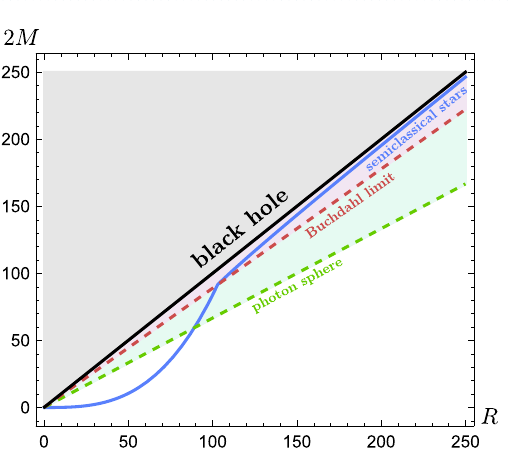
Figure 3. The left and right panels denote the parameter space for the analytical-pressure core of stars with R ≃ 163, C R = 1 − 10 − 4 . We have chosen r core / R = 0.037 and r core / R = 0.125 for the core radius, respectively. The colored region denotes entirely regular solutions. The horizontal axis is the quotient between the central and the core-boundary pressures p 0 , p core . The vertical axis is the quotient between the second derivatives of the pressure at the origin, p ′′ 0 , and at the core boundary, p ′′ core .